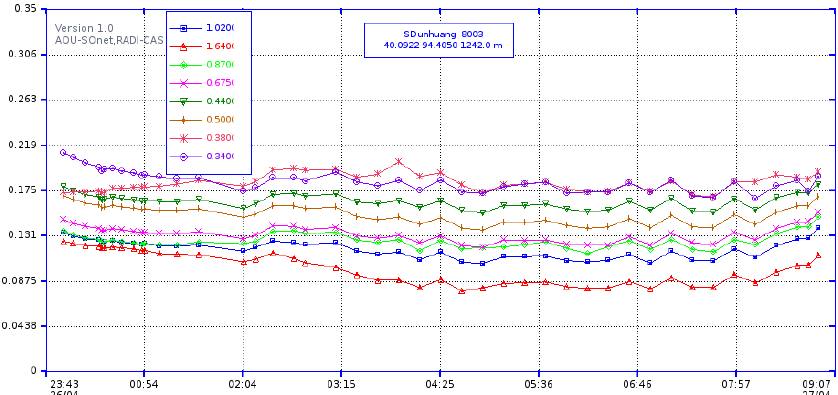
Figure 6. The ground-based measured spectral aerosol optical depths at Dunhuang on 27 April 2017 (UTC time).